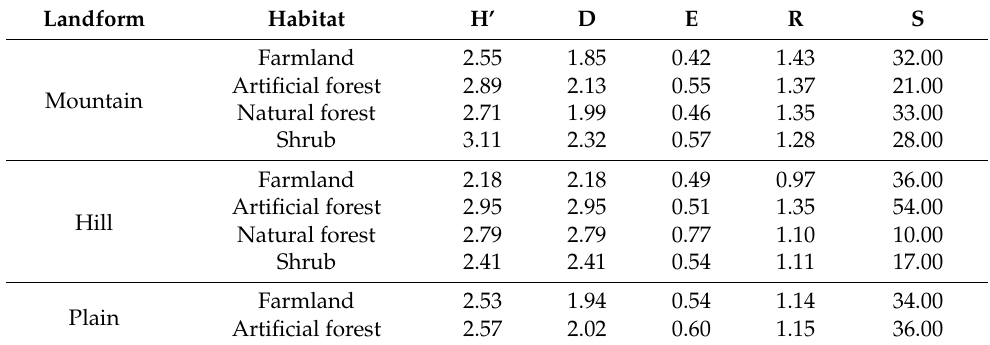
Table 2. Biodiversity indices in the study